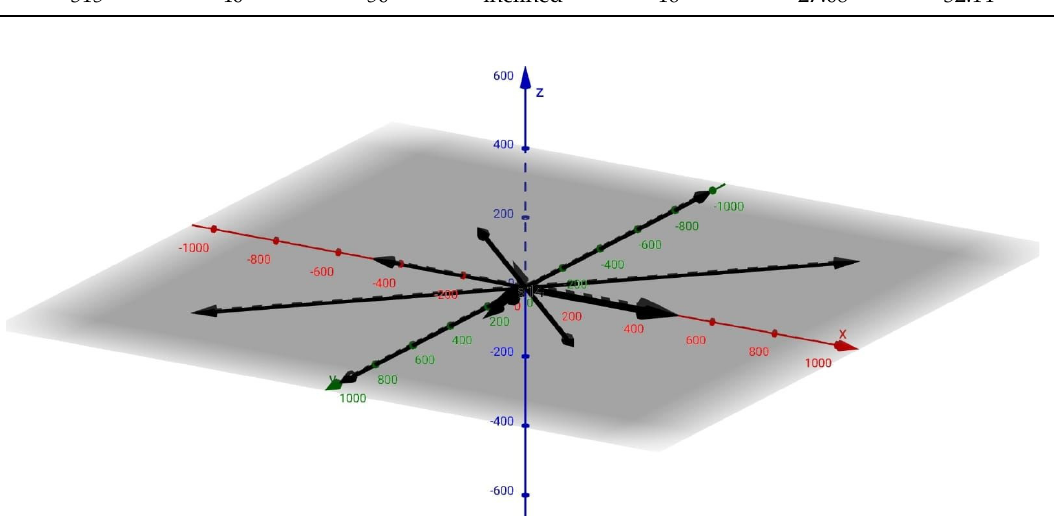
Figure 4. Plot of variogram ranges in 3D space, which indicates a 3D ellipsoid anisotropy.